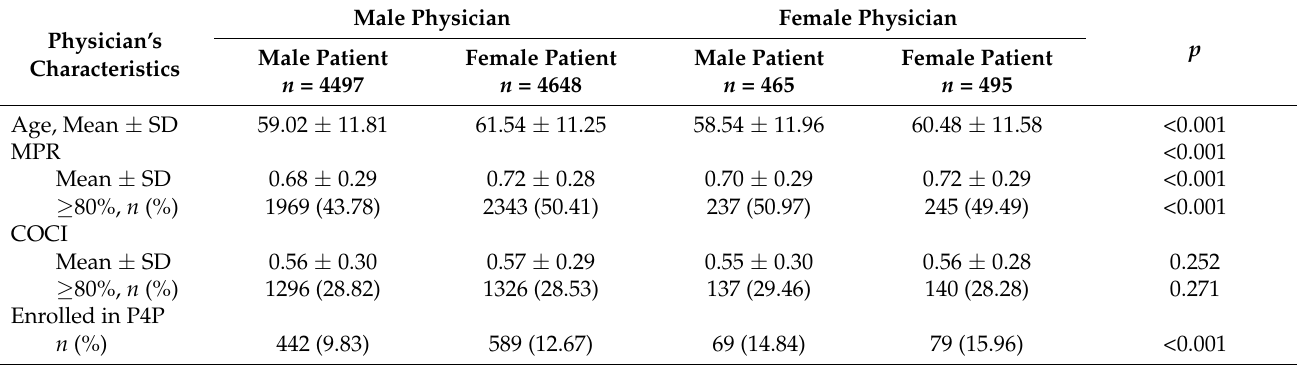
Table 4. Comparisons of MPR, COCI, and enrolment in P4P between patients stratified by sexes of patient and physician. Physician’s